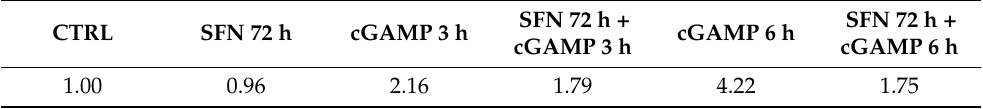
Table 1. IFN scores of IHH cells treated with SFN and cGAMP.